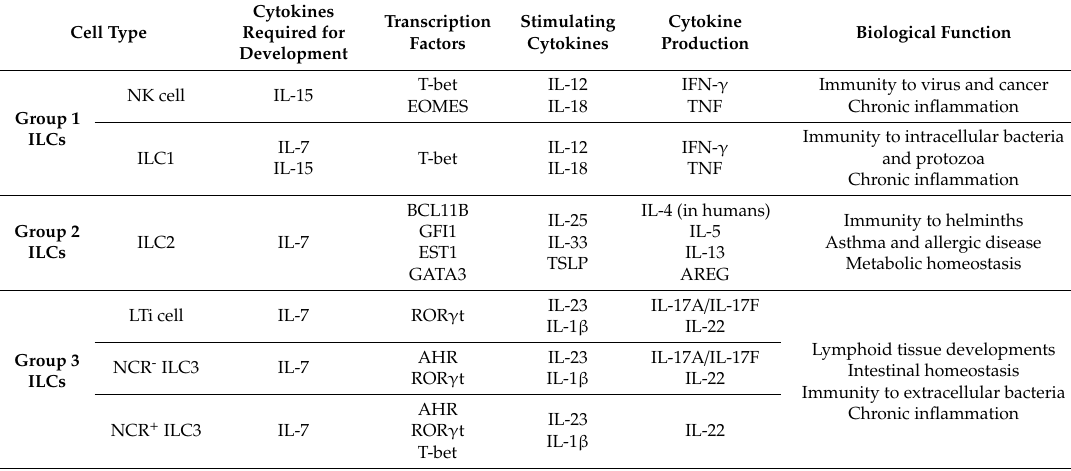
Table 1. Classification of ILC